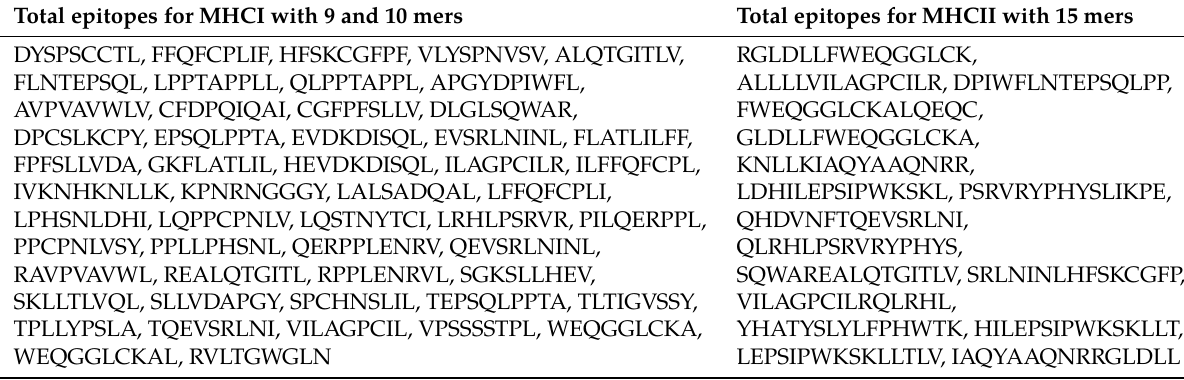
Table 1: Selected epitopes for both MHCI and MHCII from IEDB. Total epitopes for MHCI with 9 and 10 mers Total epitopes for MHCII with 15 mers